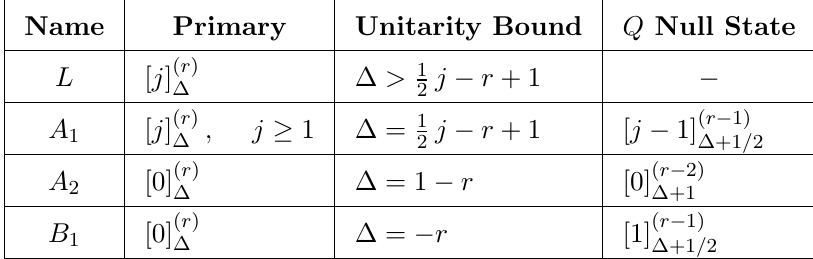
Table 2 . Q shortening conditions in three-dimensional N = 2 SCFTs.